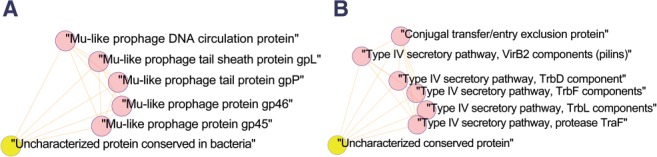
Functional modules of co-evolving genes that include an uncharacterized member. (A) ‘Mu-like prophage’ cluster (B) ‘Type IV secretory pathway’ cluster. Yellow nodes correspond to COGs that are uncharacterized